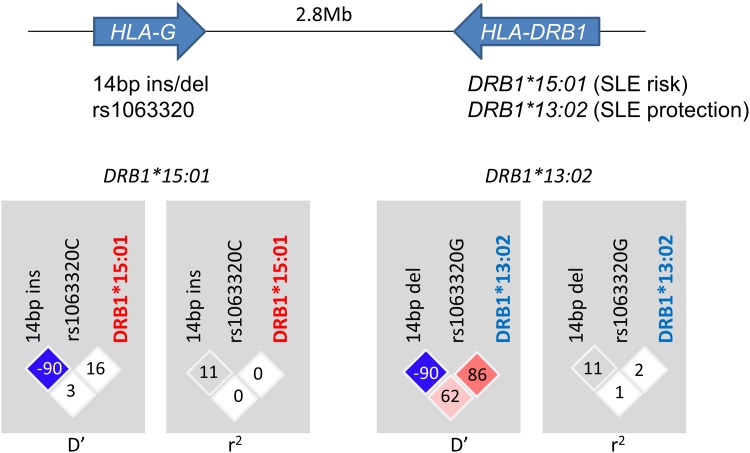
Linkage disequilibrium parameters between HLA-G 14bp indel, rs1063320 and DRB1*15:01 or DRB1*13:02.LD was detected between DRB1*13:02 and HLA-G 14bp del and, more strongly, rs1063320 G. Only weak LD was observed between DRB1*15:01 and HLA-G alleles. Negative LD was observed between HLA-G 14 bp ins and rs1063320 C (shown in blue matrix in the LD plot).